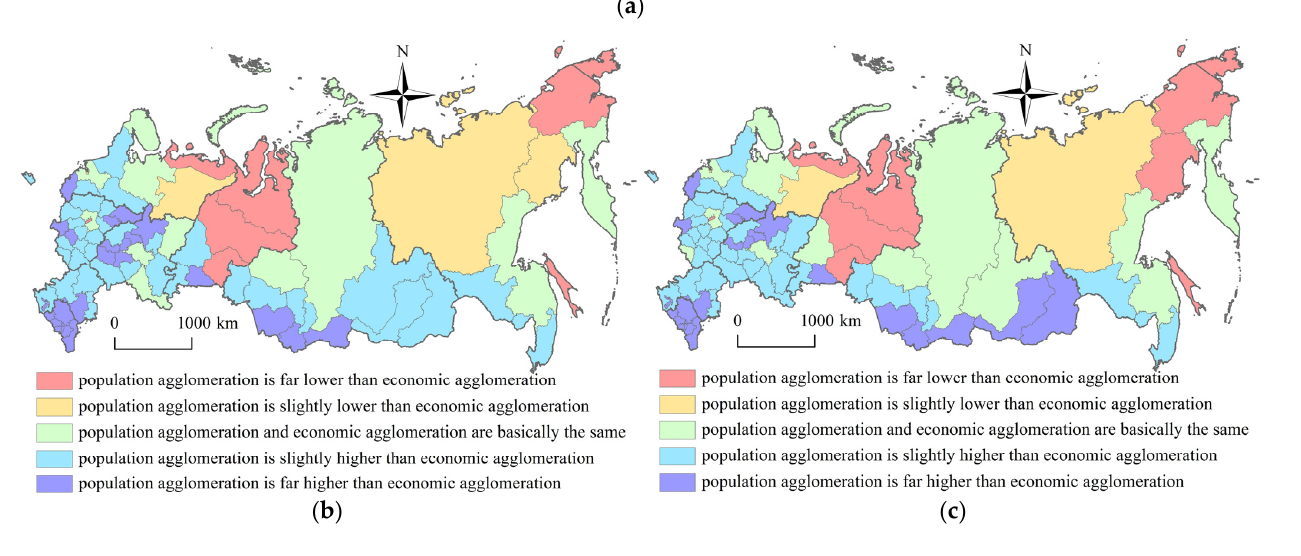
Figure 5. Spatial pattern of population-economy inconsistency in Russia during 2002–2020. ( a ) 2002 Table 1. Classification of population-economy inconsistency types in Russian federal subjects.